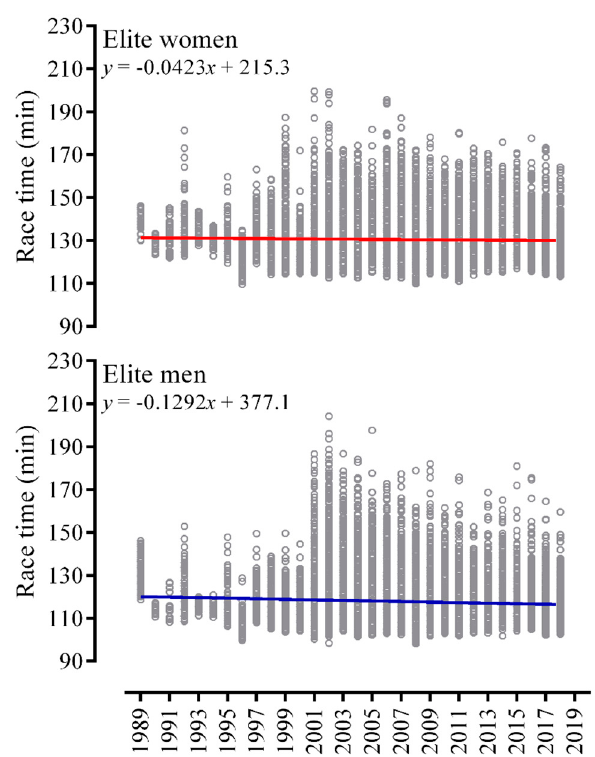
Figure 1. Performance trend of overall race time in Olympic distance triathlon from 1989 to 2019 in men and women.